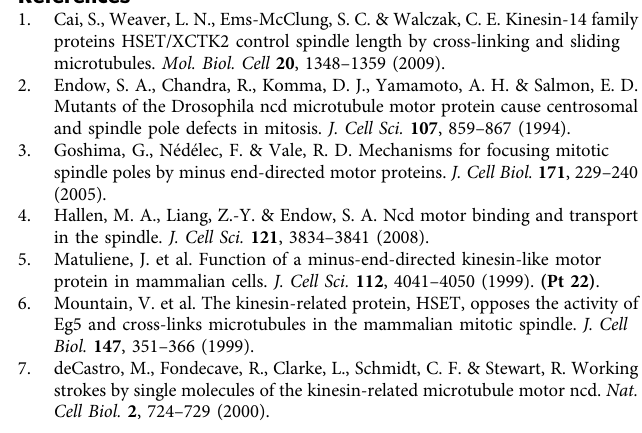
the fi t. The no-load transport velocity was measured independently either before or after the force-velocity measurements and there was no signi fi cant difference between velocities measured before or after microsphere attachment (Supplementary Figure